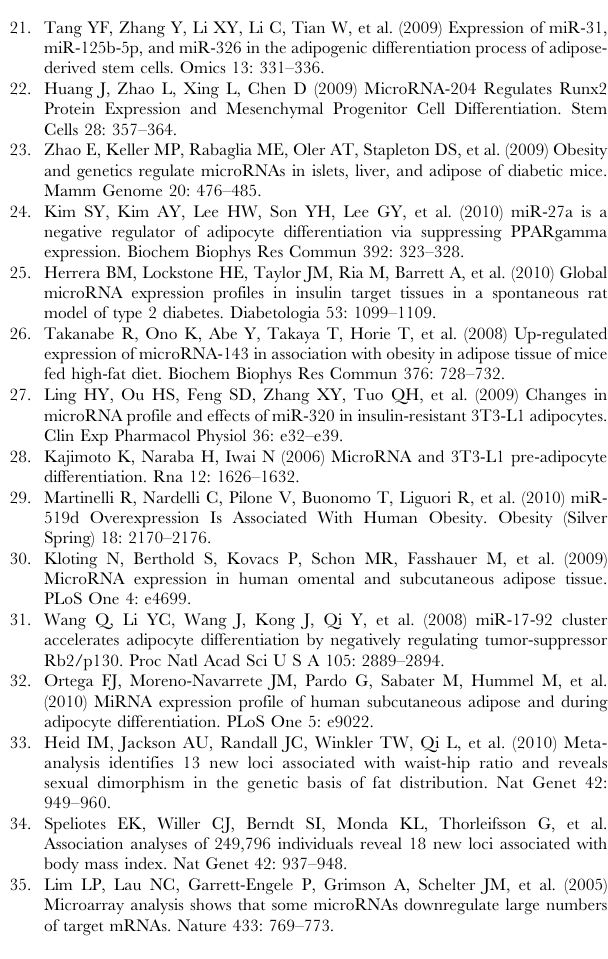
Table S1 Candidate set of tissue differentially expressed miRNAs from the primary study together with results from the confirmation study. Table S2 miRNA associated with metabolic syndrome case- control status in abdominal adipose tissue. Table S3 miRNA associated with metabolic syndrome case- control status in gluteal adipose tissue. Table S4 Candidate set of miRNA eQTLs in abdominal adipose tissue from the primary study together with results from the confirmation study. Table S5 Candidate set miRNA eQTLs in gluteal adipose tissue from the primary study together with results from the confirmation study. Table S6 Genome-wide association analysis results of eQTL SNPs in relation to BMI and waist/hip ratio adjusted for BMI. Table S7 miRNAs significantly associated with their mRNA targets in abdominal adipose tissue.